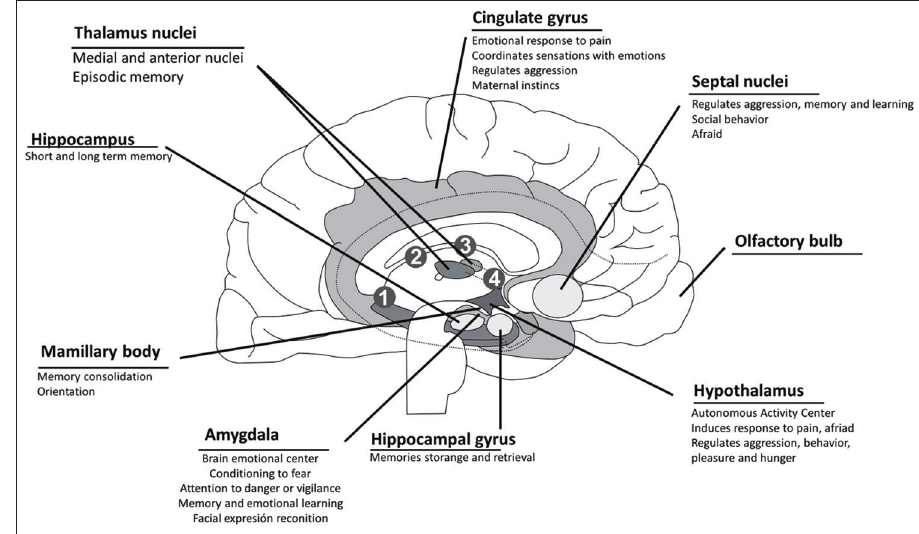
Figure-2: The limbic system and its participation in sensations of pain and anxiety